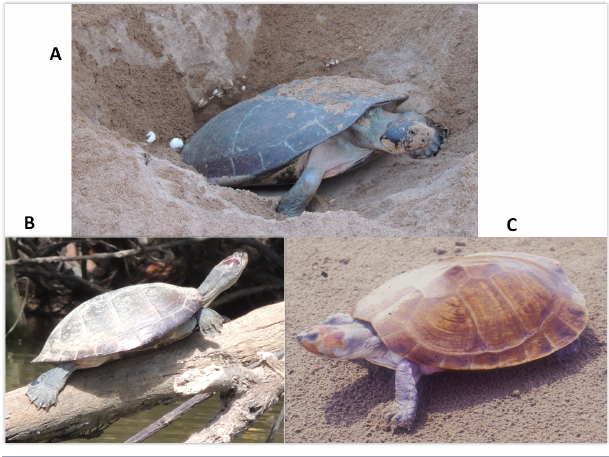
Fig. 1 . Three turtle species that nest in the lower Amazon: (A) tartaruga ( Podocnemis expansa ); (B) pitiú ( P. sextuberculata ); (C) tracajá ( P. unifilis